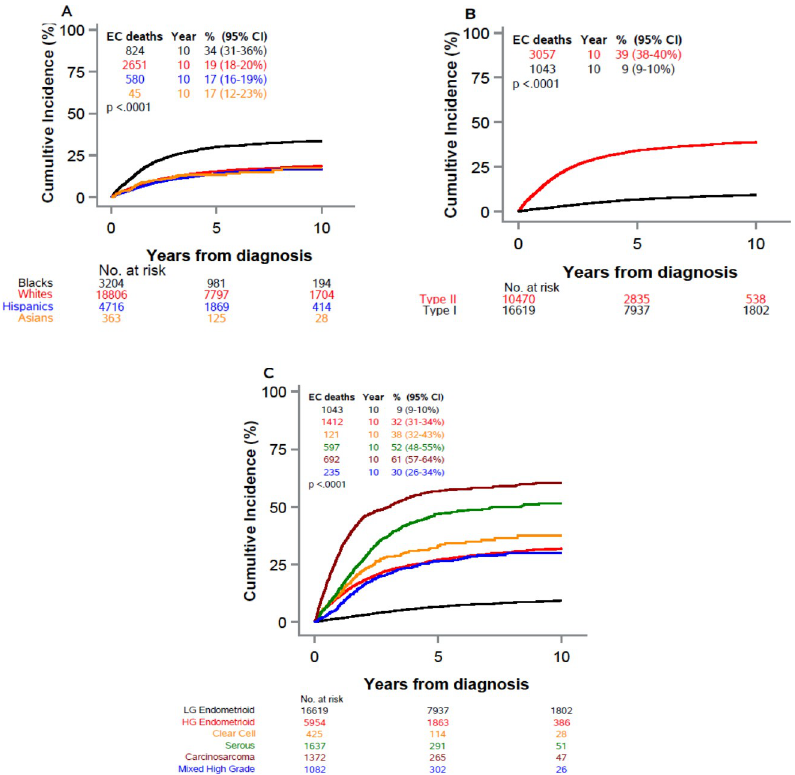
Fig 1. Cumulative incidence of EC mortality, with death from other causes as a competing risk, among women with endometrial cancer (Florida 2005–2016); by race/ethnicity (A), by EC type (B), and for specific type 2 EC by histological subtype (C). Legend: p:-value from Gray’s test comparing cumulative incidence curves. Censored observations not shown. Maximum follow-up truncates at 10 years.